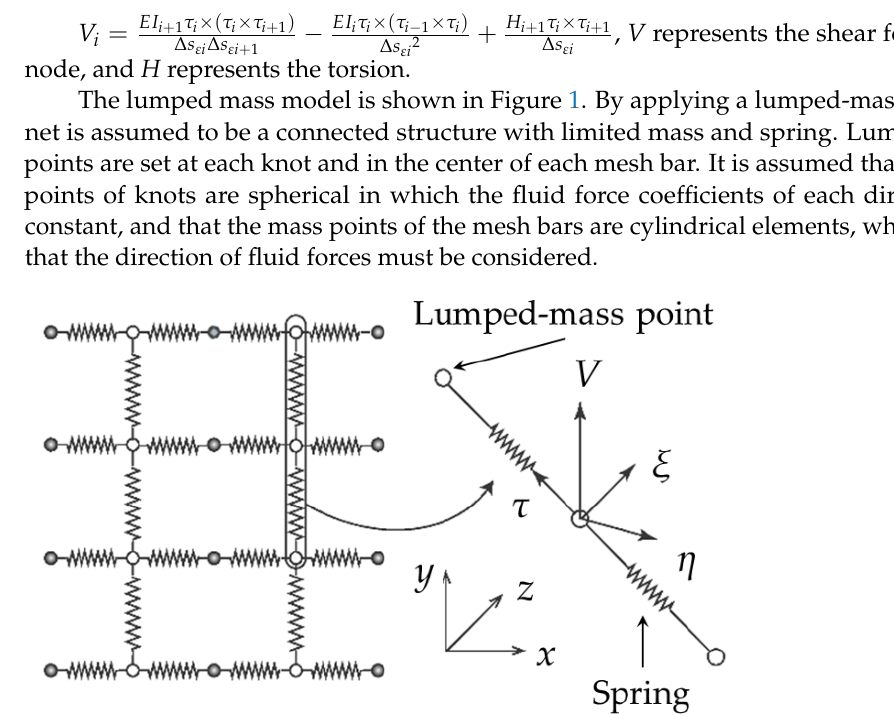
Figure 1. The lumped mass model.